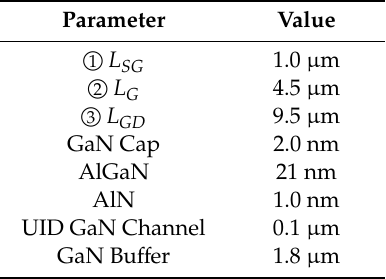
Table 1. Basic AlGaN / GaN-based HEMT geometrical parameters.